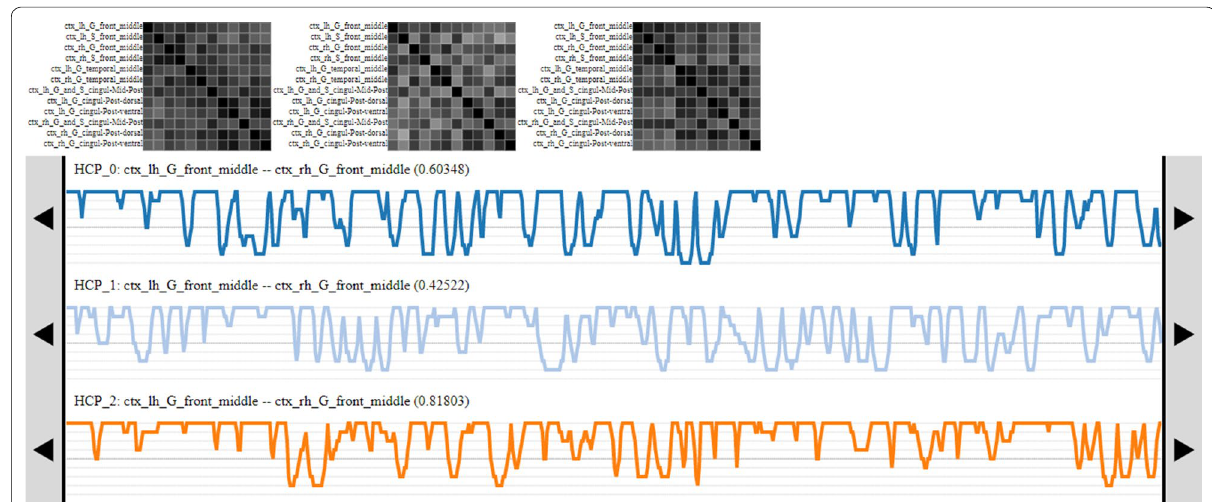
Fig. 4 The TemporalTracks interface. The FCN matrices at the top change to reflect the user modifications to the tracks below. Each track shows the pairwise coactivation beween two ROIs—when lines are at the top, the ROIs highly coactive and when the lines are at the bottom, the ROIs are not very coactive